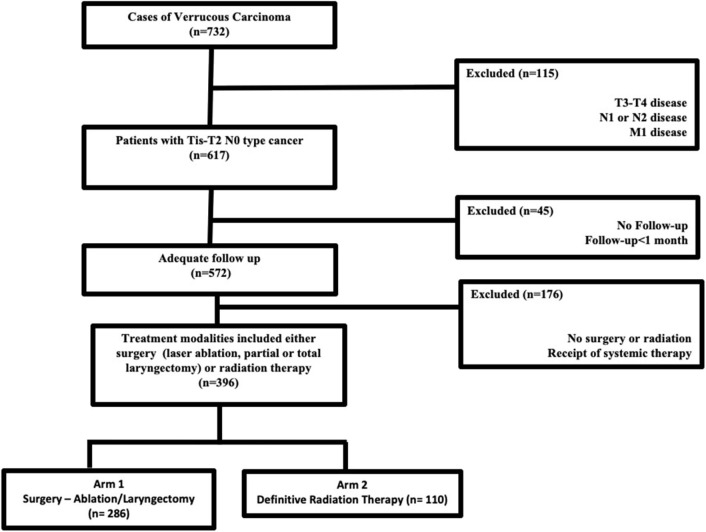
CONSORT diagram outlining the selection criteria for study eligibility.